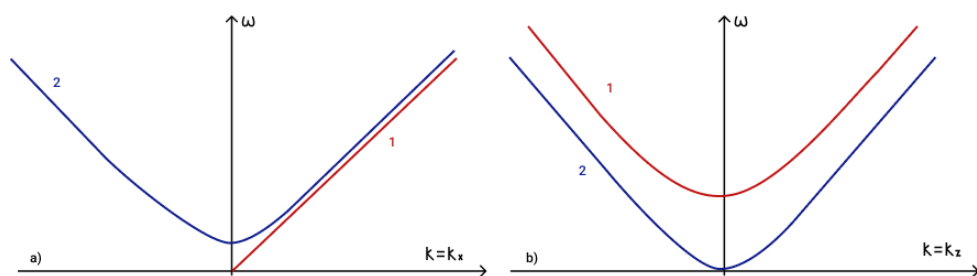
Figure 7. Dispersion curves for ( a ) 1—Alfven wave ω A and 2—magnetogravity wave ω mgr ; ( b ) 1— magnetic wave with frequency ω z 1 and 2—magnetic wave with frequency ω z